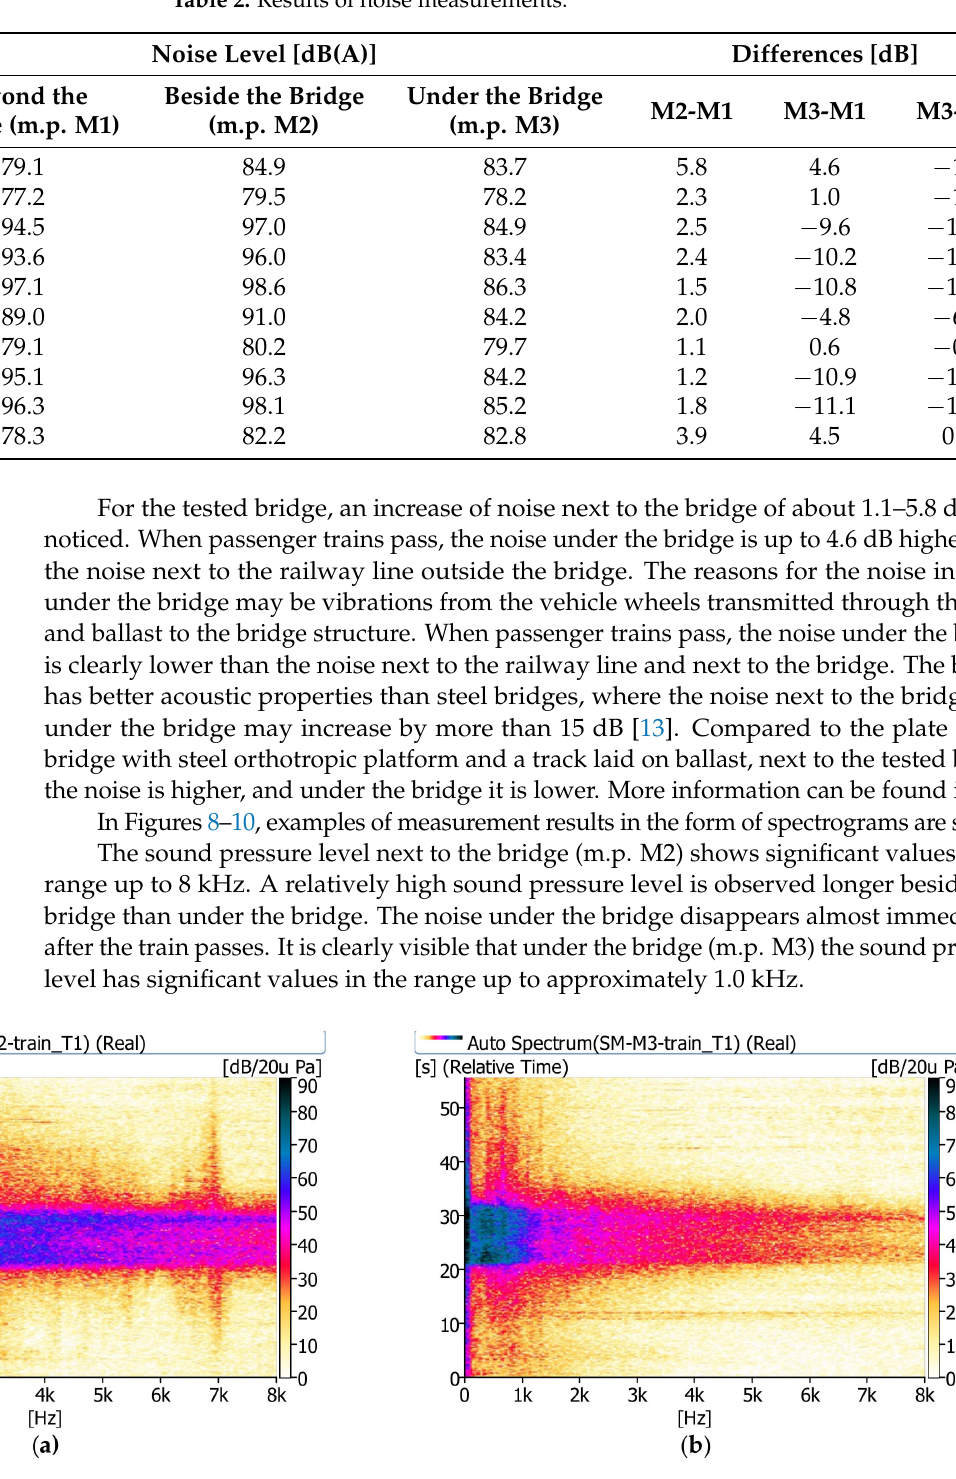
Figure 8. Spectrograms recorded during the passage of a cargo train (T1): ( a ) next to the bridge (m.p. M2), ( b ) under the bridge (m.p.